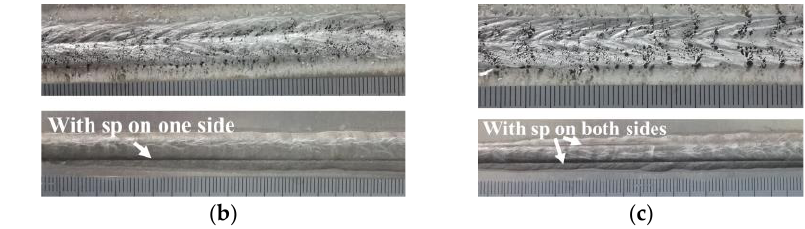
Figure 9. Appearance of beads with different supporting plates on ( a ) whole cross-section; ( b ) one side; ( c ) both sides.